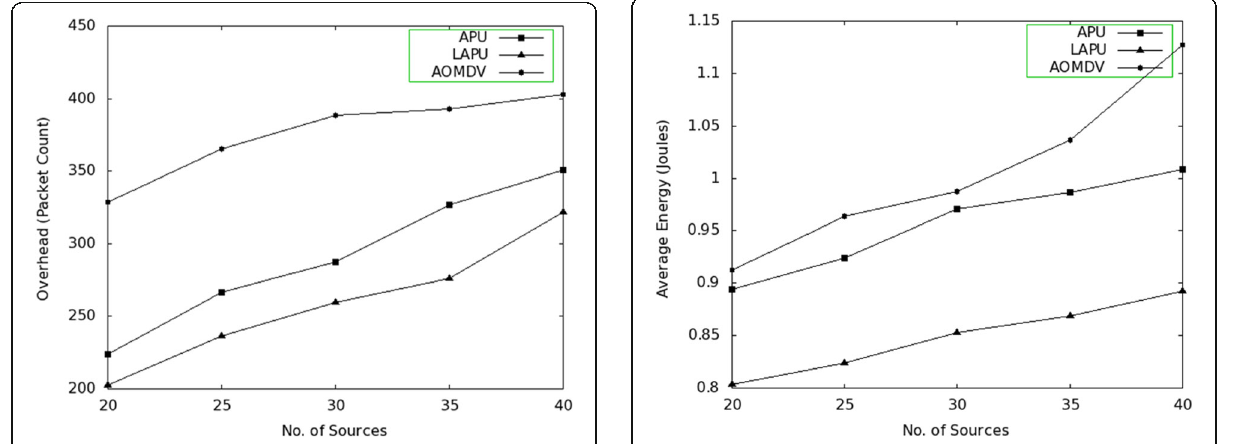
Fig. 10 Routing overhead vs. number of sources